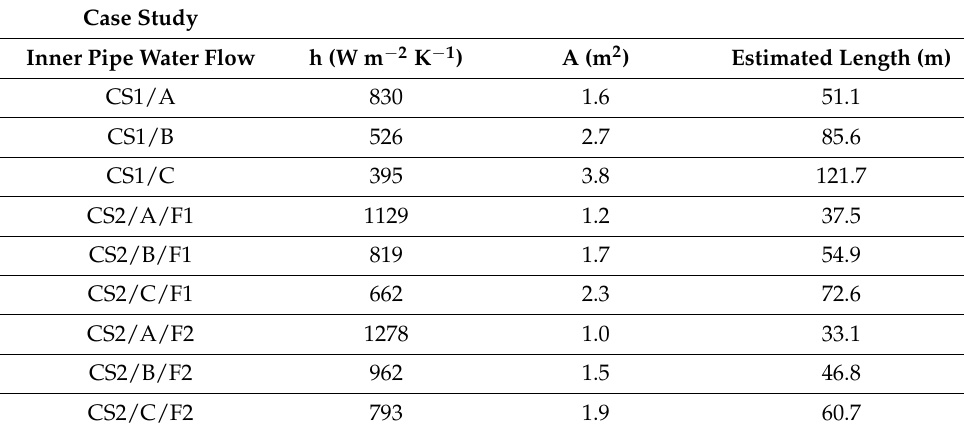
Table 7. Overall heat transfer coefficient and necessary heat transfer